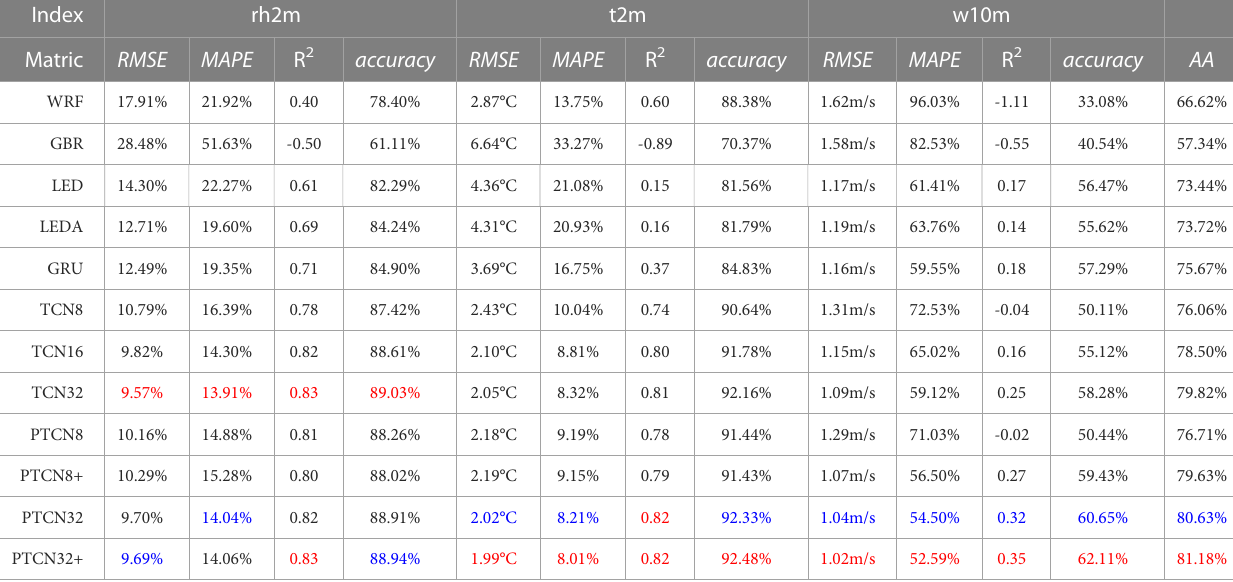
TABLE 2 Comparison of proposed methods with some popular sequence prediction methods on WFD2018 aic (2018a).